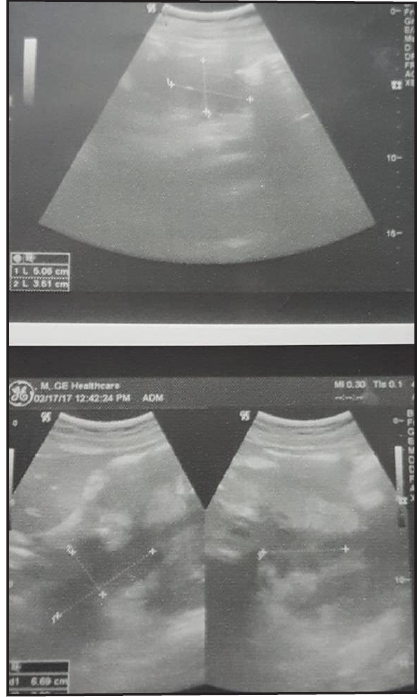
Figure 1. USG showing swollen pancreas.